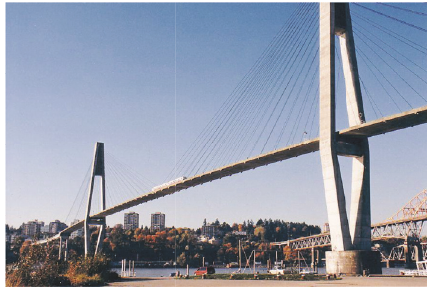
Figure 14: The Skytrain Bridge.